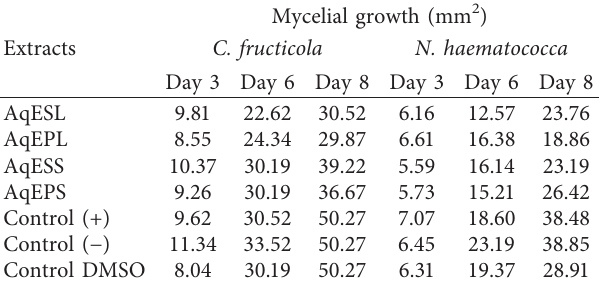
Table 1: Effect of aqueous extracts of papaya and soursop leaf and seed on the mycelial growth of C. fructicola and N. haematococca after different days of incubation. Mycelial growth (mm 2 Extracts